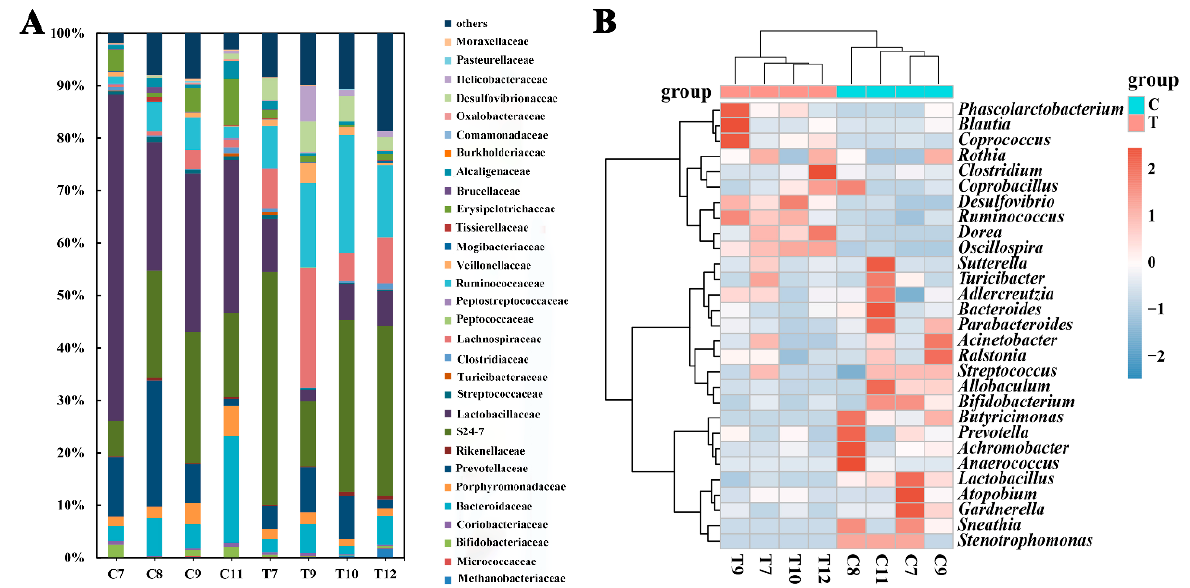
Figure 2. Alpha-diversity and Beta-diversity of Sprague Dawley Rats after CF11 intervention for 21 days. ( A ) Alpha-diversity index (Shannon index, observed_OTUs, and PD_whole_tree) of the gut microbiome in Sprague Dawley Rats, CF11 intervention for 21 days. ( B ) Weighted and unweighted Unifrac distance. Microbial richness estimates and diversity indices were measured at OTUs defini- tion of >97% identity. C (control group, day 21), T (experimental group, day 21), n = 4 each group; Data were analyzed by one-way ANOVA. * p Value < 0.05.